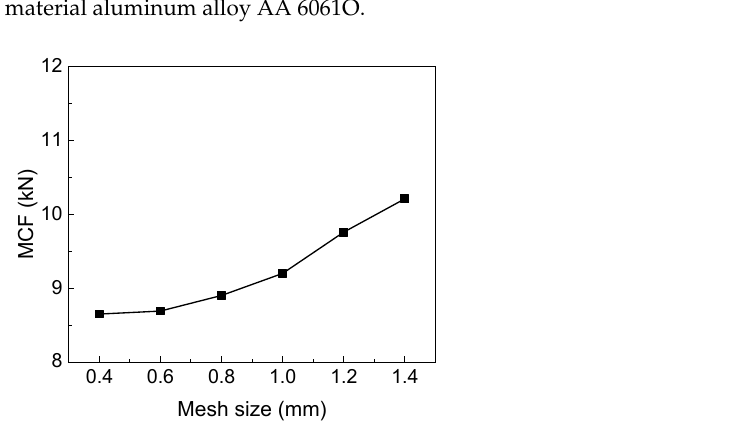
Figure 5. MCF for different mesh sizes.